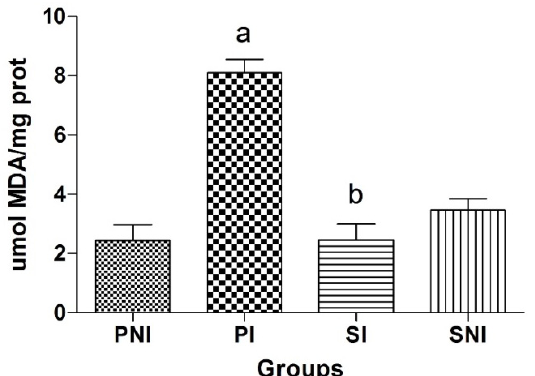
Figure 3. Thiobarbituric acid reactive substances (TBARS) levels expressed in µmol MDA/mg